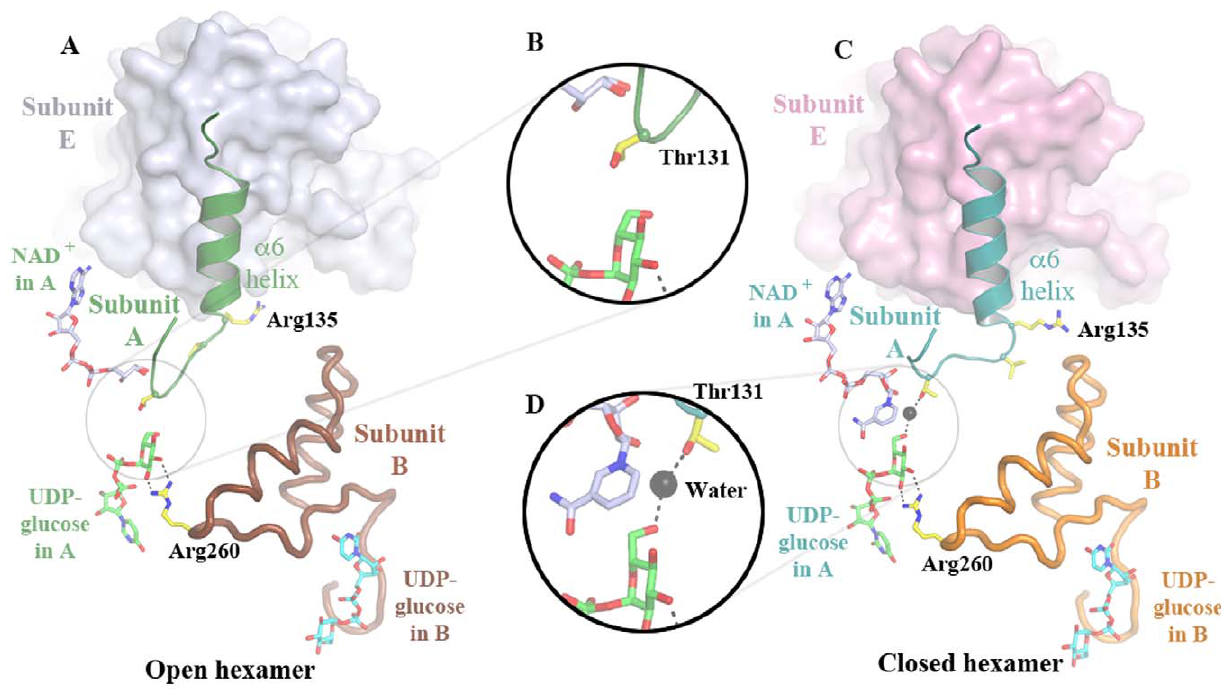
Figure 5. Cooperativity within the hUGDH trimeric unit. Here, movement of the protomer A Thr131 loop into the active water-binding site is associated with an adjustment to the a 6-helix, which mediates contact to the next protomer E in the trimeric unit. (A) Portions of protomers A (green), B (brown) and E (gray surface) from the open hexamer. (B) Close up of Thr131 in the active water-binding site. (C) Portions of protomers A (teal), B (orange) and E (pink surface) from the closed hexamer. (D) Close up of the active water-binding site. Movie S3 shows a morph between these two structures.